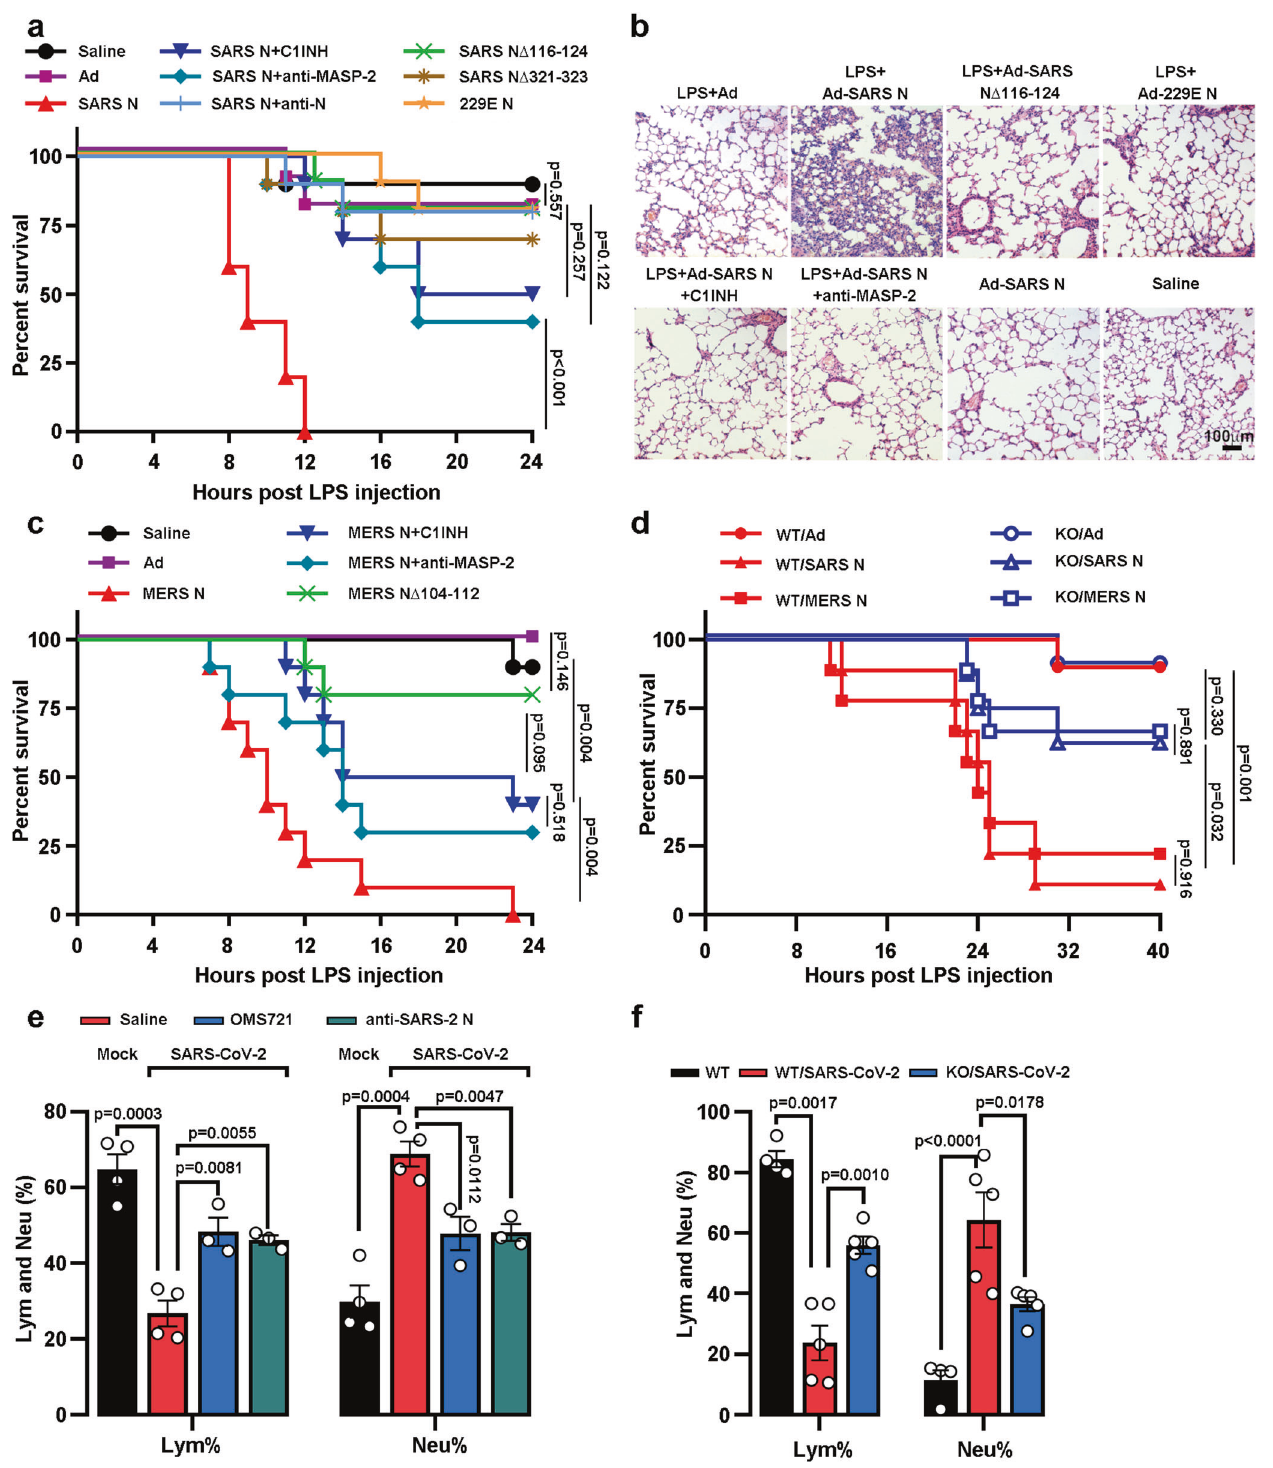
C4alpha ’ fragments, which are left by C4a release after C4 cleavage and can indicate C4 activation, and MASP-2 were detected by an immunoblot analysis with an anti-C4alpha antibody (Santa Cruz) or anti-Flag antibody (Sigma). Puri fi ed C4b (Calbiochem) containing C4alpha ’ , but not C4a, was used to indicate the C4alpha ’ band